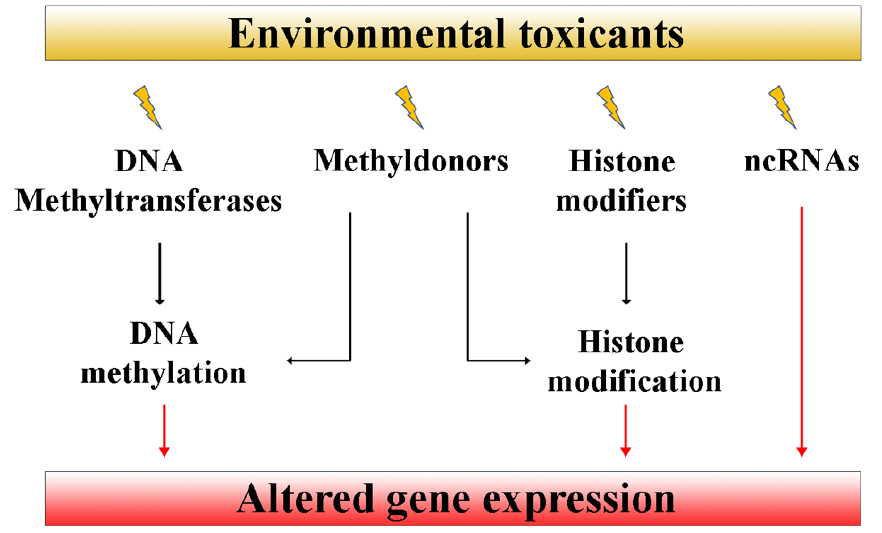
Figure 2. EDC exposure may alter DNA methyltransferases, histone modifiers and noncoding RNAs with downstream effects on the gene expression.